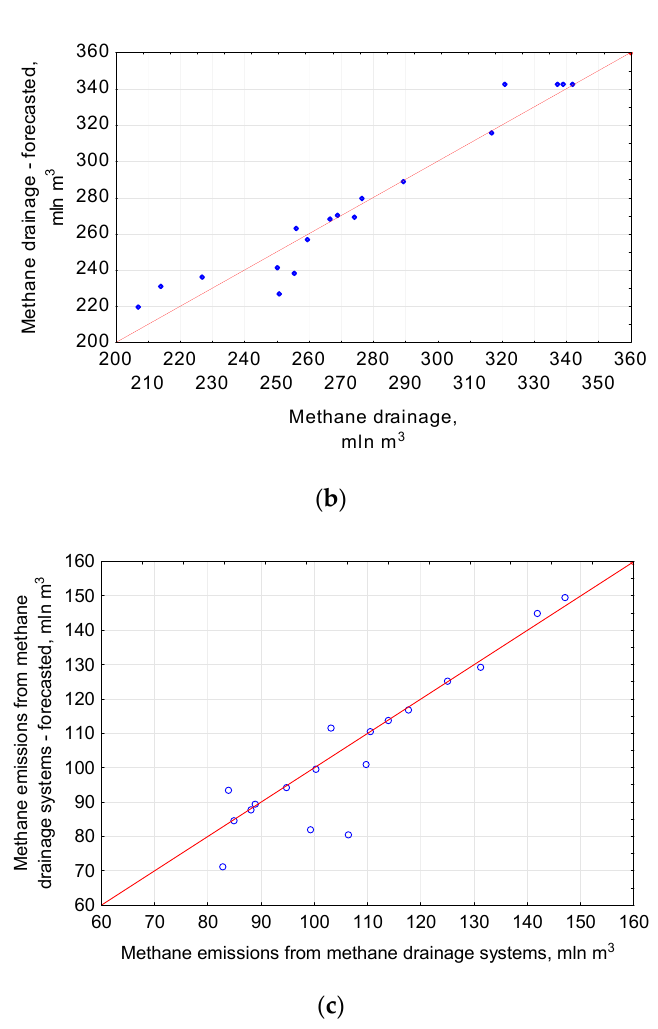
Figure 19. Predicted versus actual values of ventilation methane emissions into the atmosphere ( − ), methane drainage ( b ), and methane emissions from methane drainage systems into the atmosphere ( c ).